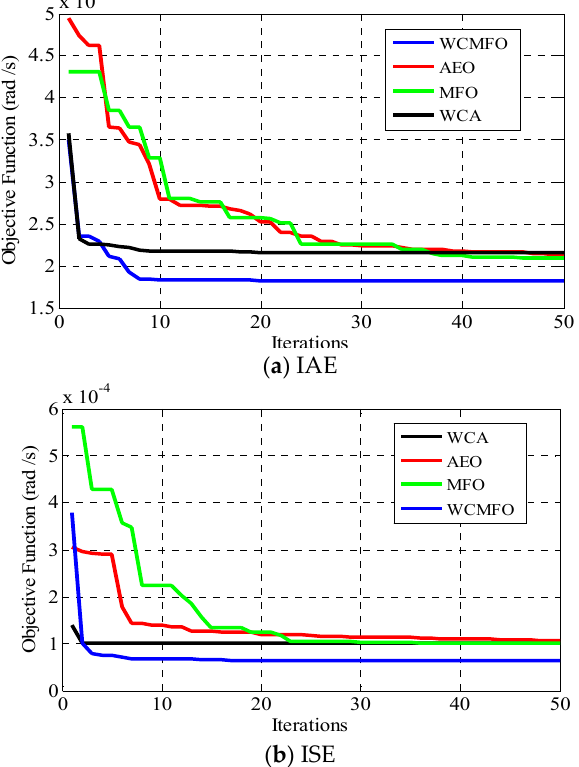
Figure 4. Convergence profile ( a ) IAE, ( b ) ISE using PID-PSS